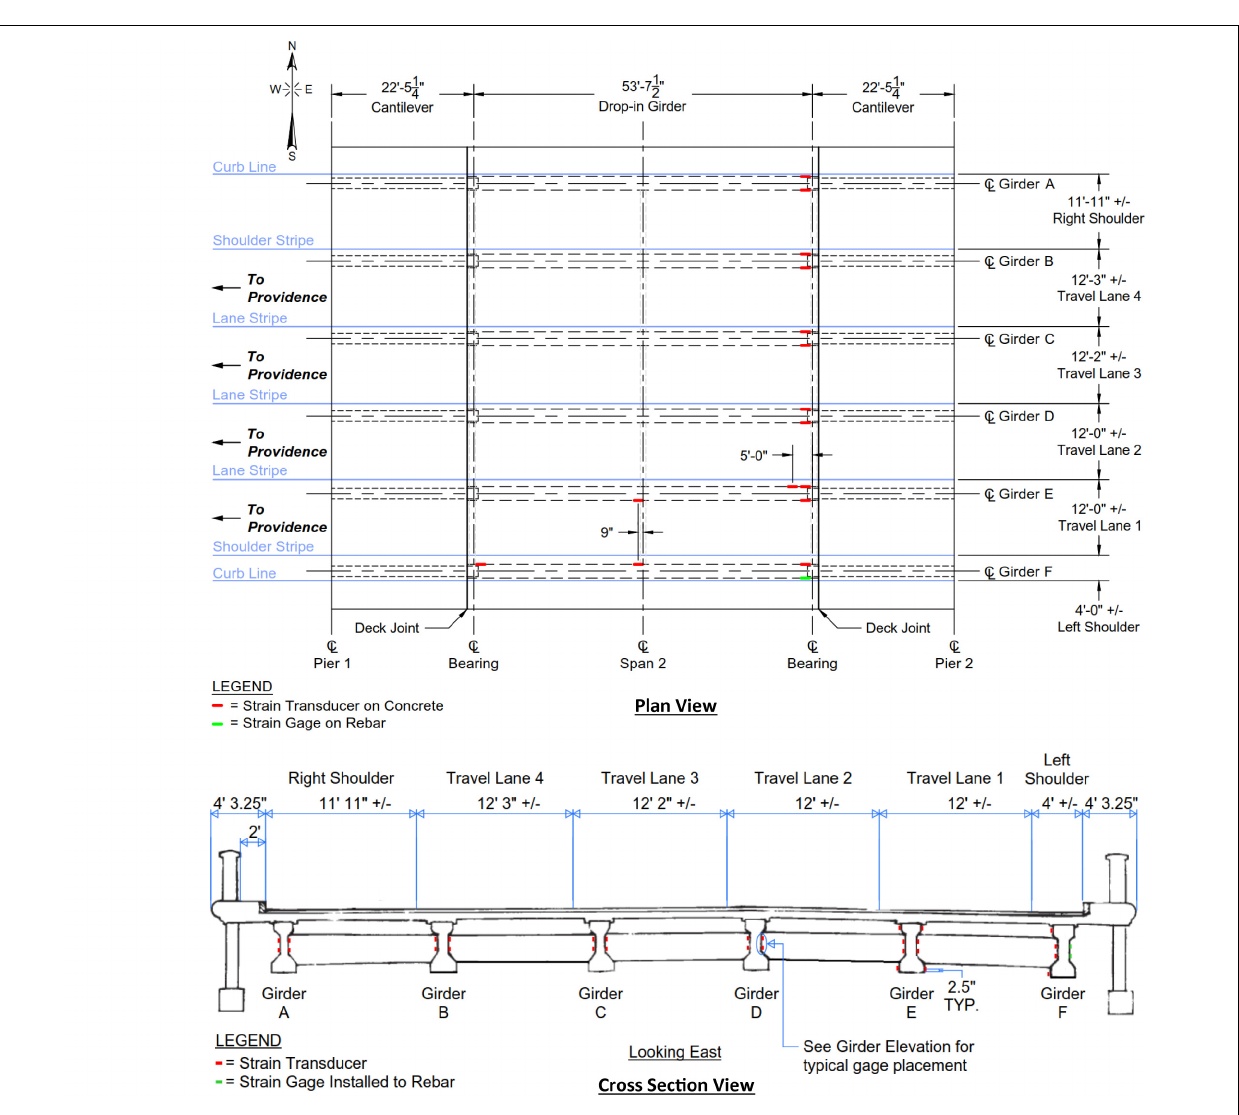
FIGURE 3 | Reinforcing details at dapped end and prestressing strand path of drop-in girder.